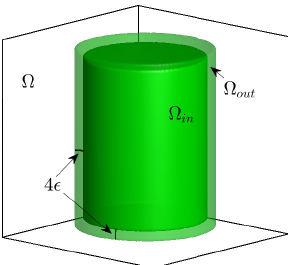
Figure 18. Schematic diagram illustrating a surface in the cubic domain Ω